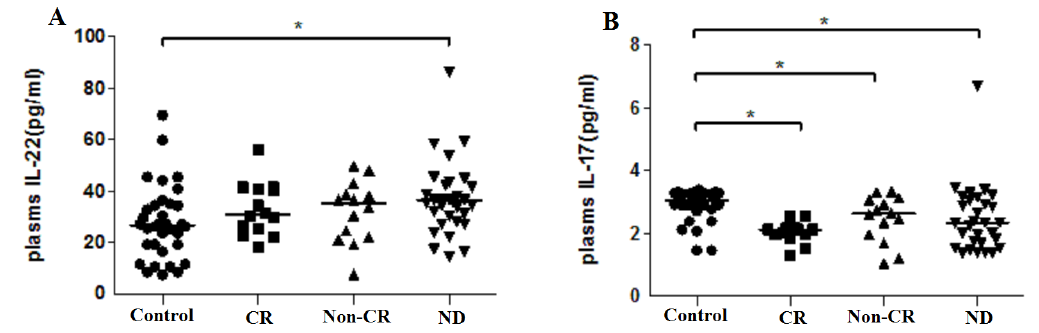
Figure 3. Results of cytokines in plasma from ND, Non-CR and CR AML patients and healthy controls. ( A ) Concentration of IL-22; ( B ) Concentration of IL-17. Data was shown as Median (range). * p <